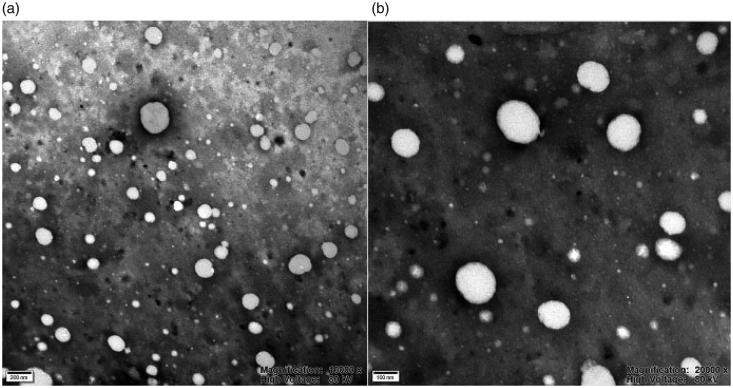
TEM photograph of Cur-P-NPs. (a) 10,000 × magnification; (b)
20,000 × magnification.